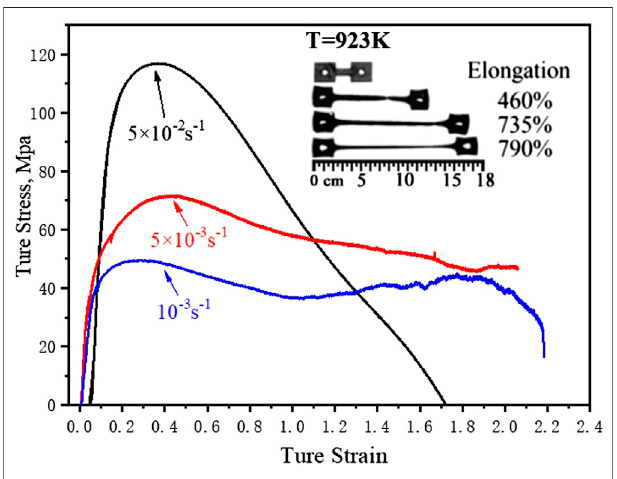
FIGURE 3 | Superplastic tensile stress-strain curves of Ti-6Al-4V (T (cid:2) 923 K).